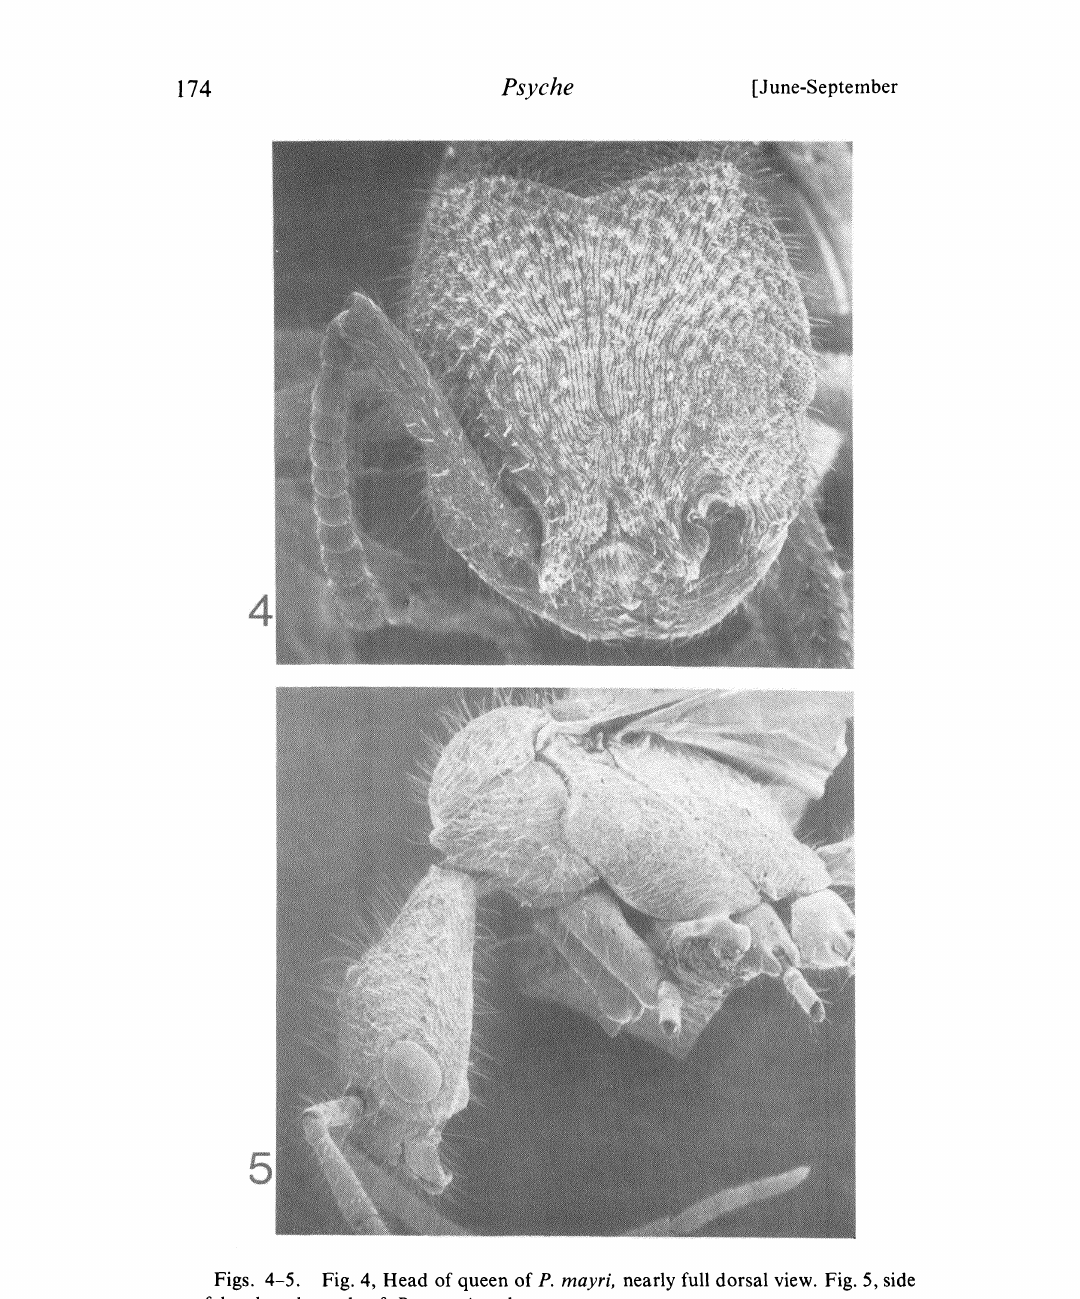
Figs. 4-5. Fig. 4, Head of queen of P. mayri, nearly full dorsal view. Fig. 5, side of head and trunk of P. mayri